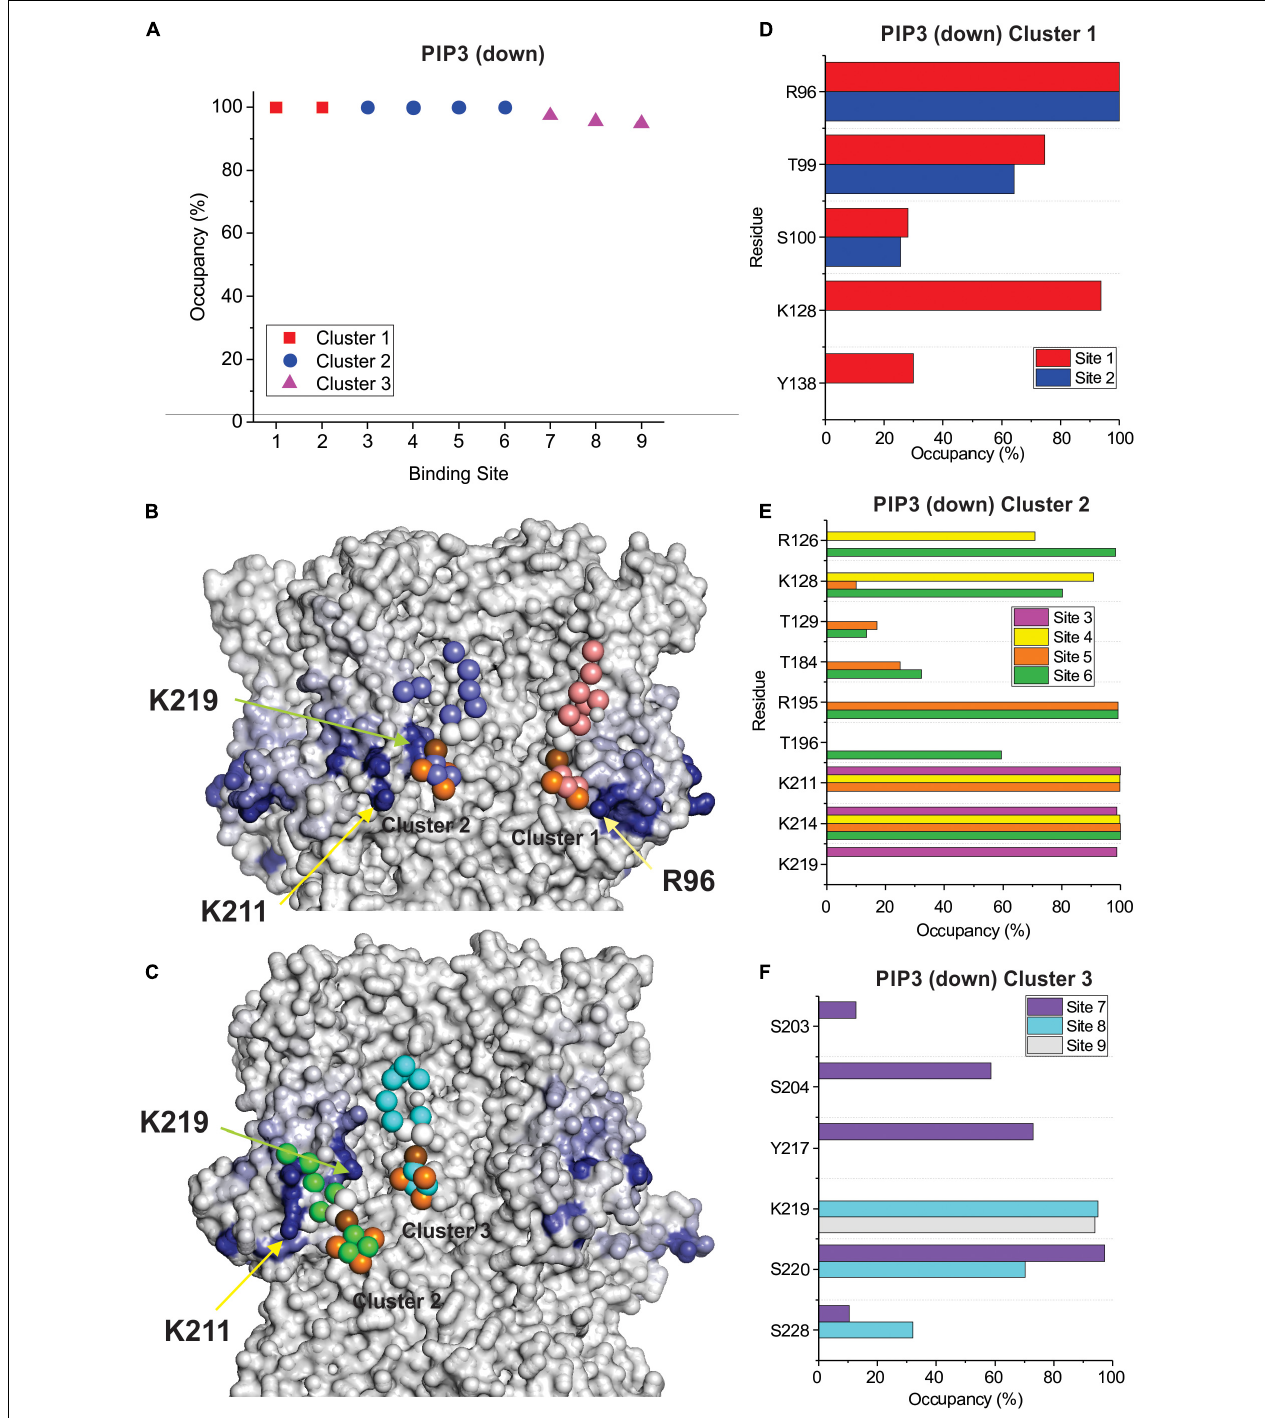
FIGURE 6 | PIP3 binding to HCN1 with down (activated) VSDs examined by coarse-grained simulations. (A) Occupancy (percentage of frames) of each lipid binding site in the HCN1 tetramer identified and quantified using PyLipid software. Binding sites were clustered according to the commonality of residues involved in binding. Three binding sites for PIP3 were identified. (B,C) Snapshots of PIP3 lipids (colored balls) bound to HCN1 (surface representation). Residues are colored according to occupancy throughout the trajectory from white (0%) to deep blue (100%). Notably, the occupancy of lipid binding is not confined to a few residues, but smeared over a relatively large surface involving numerous residues. (D–F) Occupancy of PIP3-HCN1 interactions for each polar residue. In common with computational docking experiments and CG simulations of HCN1 up, binding largely occurred with residues in (D) (cluster 1) the HCN domain (including R96, R126, K128) and (F) in the S2 (R195) and S3 helices (K211, K214, and K219) (cluster 2) and somewhat deeper toward the pore (cluster 3).